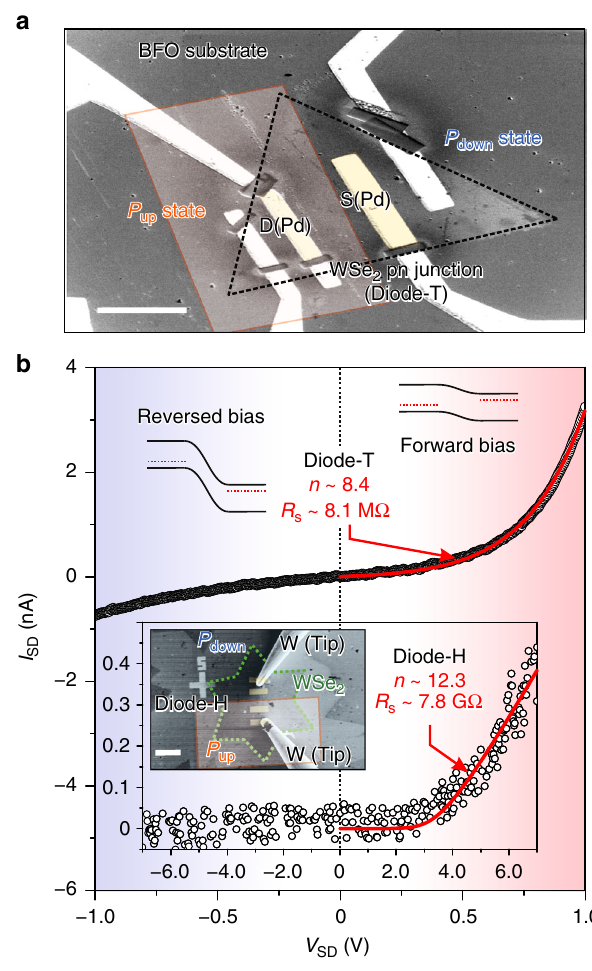
Fig. 4 The SEM images of the devices for electrical transport measurements and their corresponding I – V curves. Measurements of electrical transport of a pn homojunction in WSe 2 /BFO devices. a SEM image for a WSe 2 homojunction (Diode-T) from a top view of the junction. b Current measured as a function of voltage for the pn WSe 2 junctions on BFO (~30 nm, Diode-T) and thicker BFO (~60 nm, Diode-H) layers. The fi ts of the Shockley equation with extended series resistance at the forward- bias region give the ideality factor n and series resistance R s of WSe 2 diodes on thin (~30 nm, Diode-T) and thick (~60 nm, Diode-H) BFO layers. Both scale bars in the SEM images are 10 μ